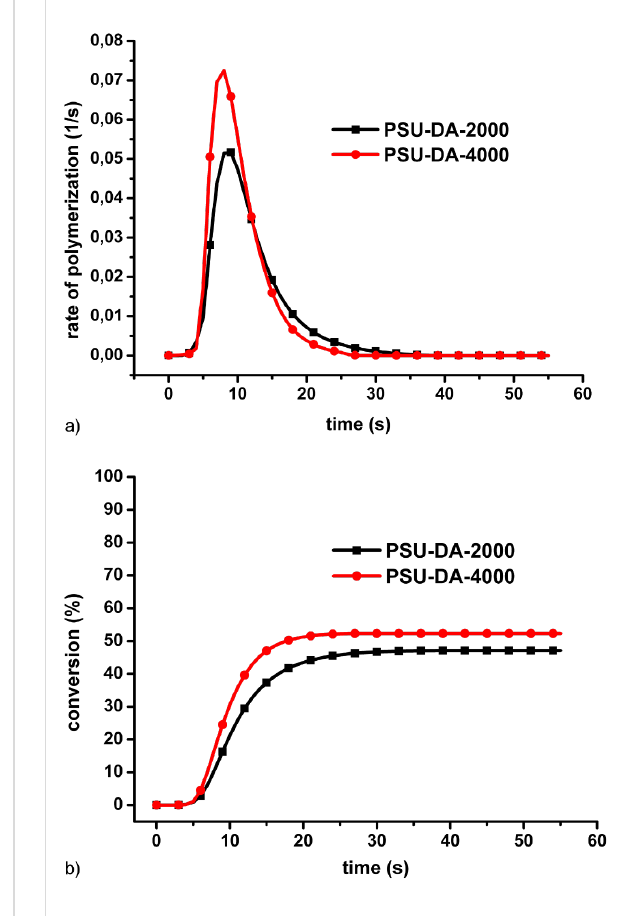
Figure 3: Rate (a) and conversion (b) of photo induced polymerization of PSU-DA-2000 and PSU-DM-2000.